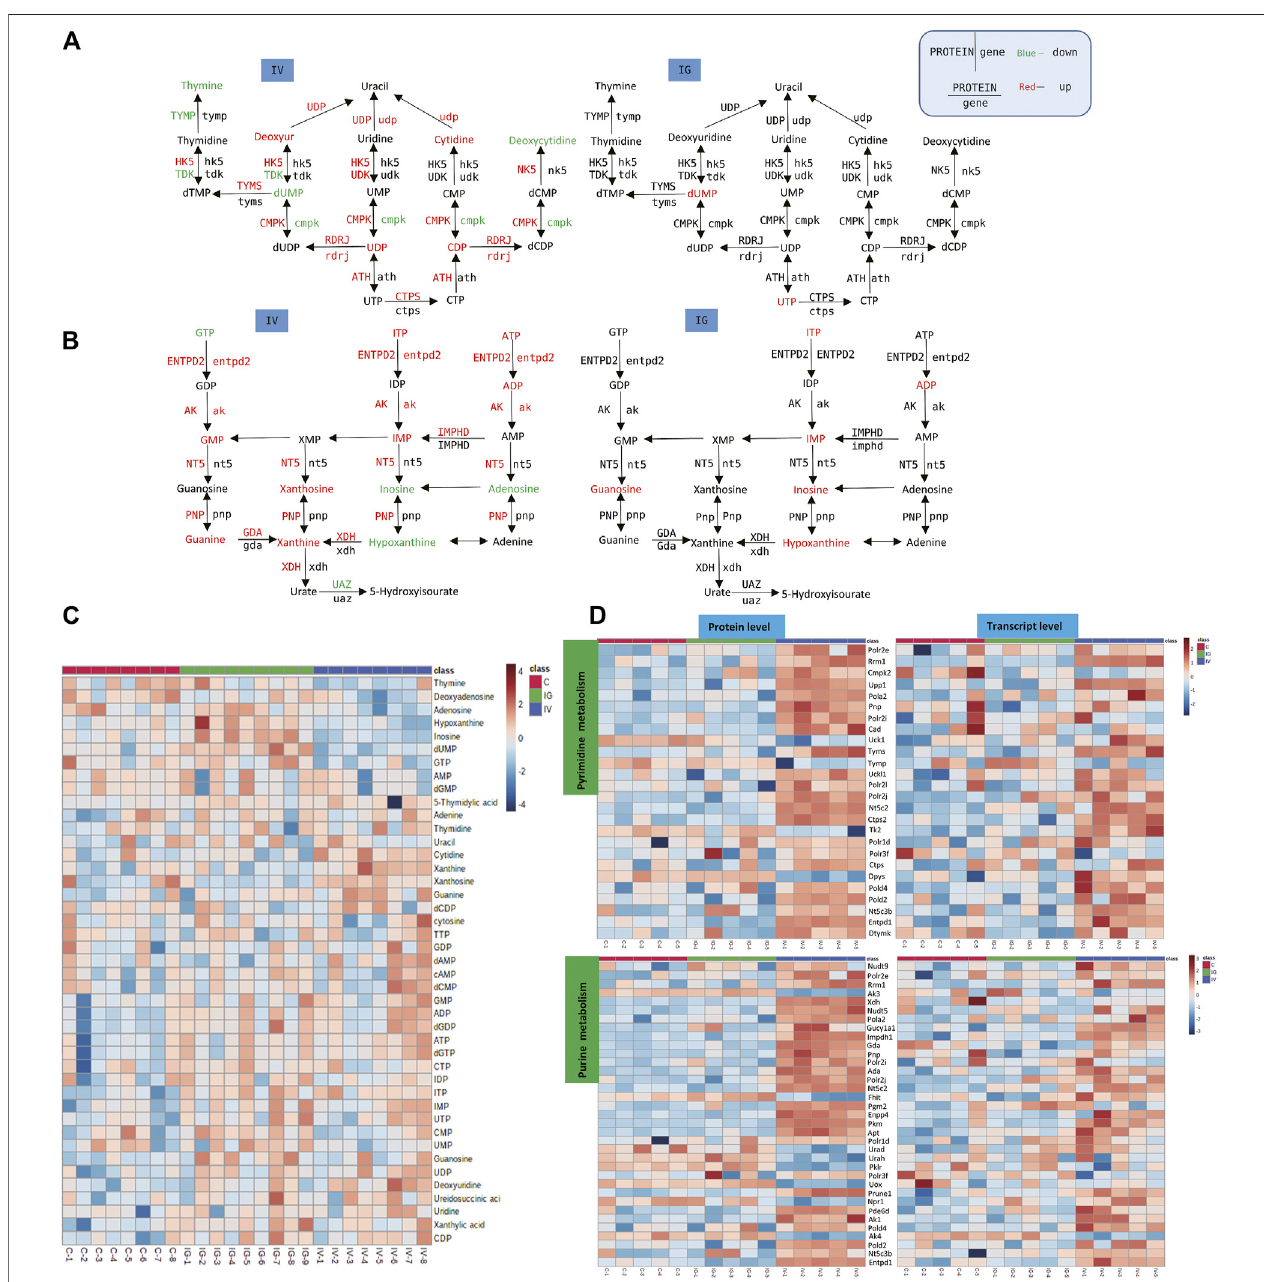
FIGURE 7 | Effect of Mesoporous Silica Nanoparticles (MSNs) on purine and pyrimidine nucleotides based on different routes of administration (IV and IG). (A, B) Schematic of purine and pyrimidine nucleotide metabolism; red indicates signi fi cant upregulation, and green indicates signi fi cant downregulation. (C) Heatmap of concentrations ofmetabolites ofpurine and pyrimidine nucleotide metabolism. (D) Heatmaps of purine and pyrimidine nucleotide metabolism based on proteomics and transcriptomics.